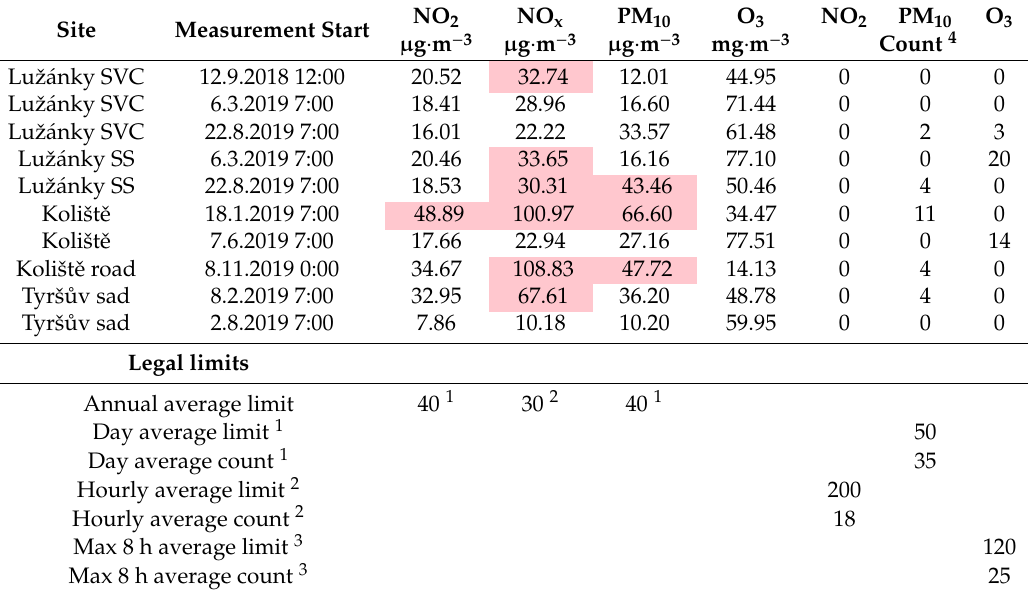
Table 5. The average concentrations from the measured localities as compared with the legal limits. Site Measurement Start